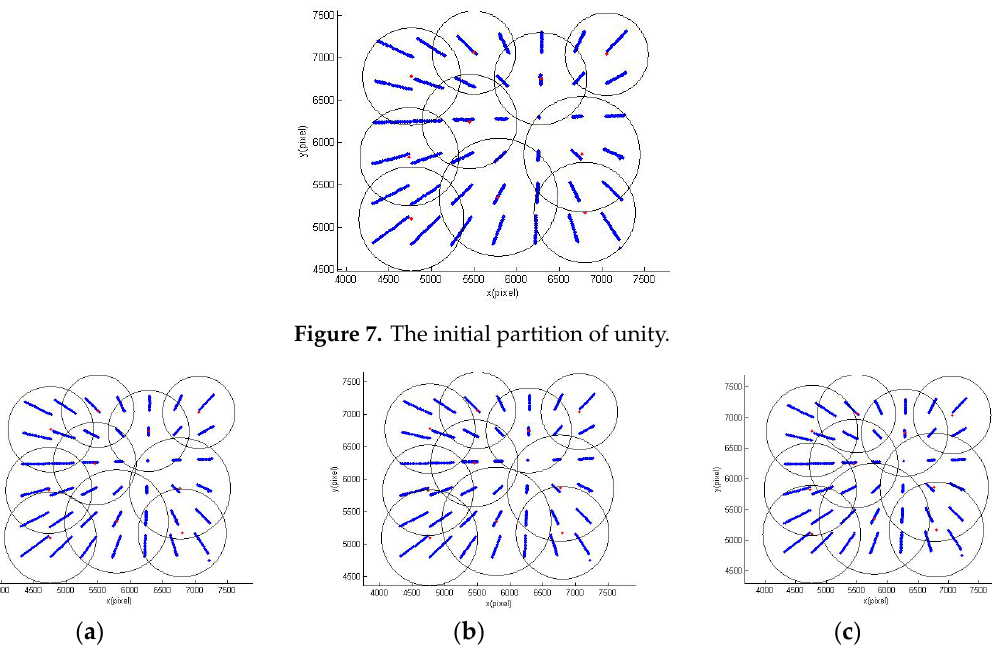
Figure 8. Partition of unity with different radius expansion coefficients: ( a ) β = 1.15, ( b ) β = 1.2, and ( c ) β = 1.3.